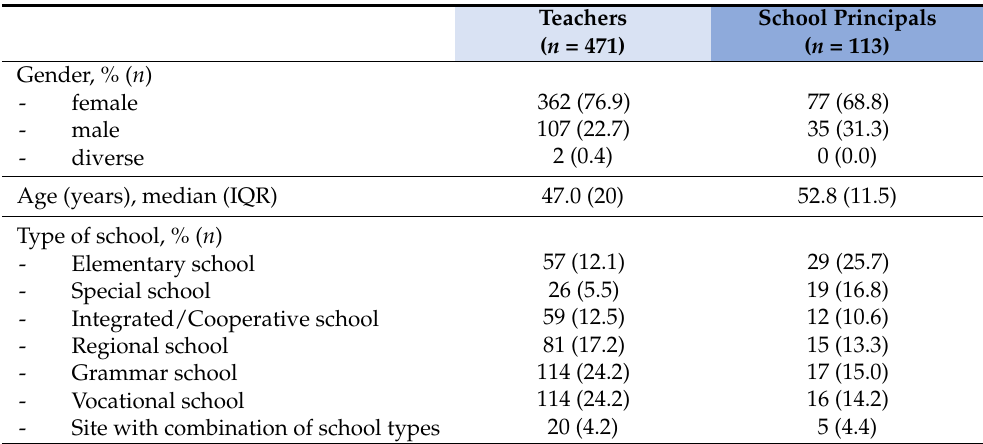
Table 2. Sample Characteristics.